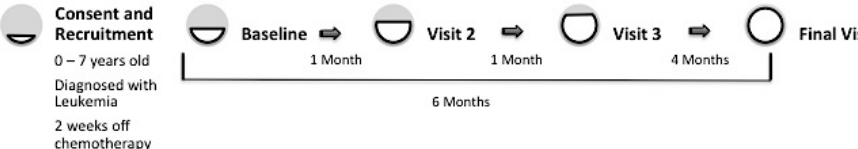
Figure 1. Scheme depicting participant progression through the study. After recruitment and informed consent, participants were scheduled for a baseline visit collecting demographic, diet (24 h recall), blood, and medical record information. Visits thereafter included all of these measurements except demographics. Participation time in the study was approximately 6 months from baseline to final visit. Progression through the study is represented by a gradually filling circle (from grey to white).